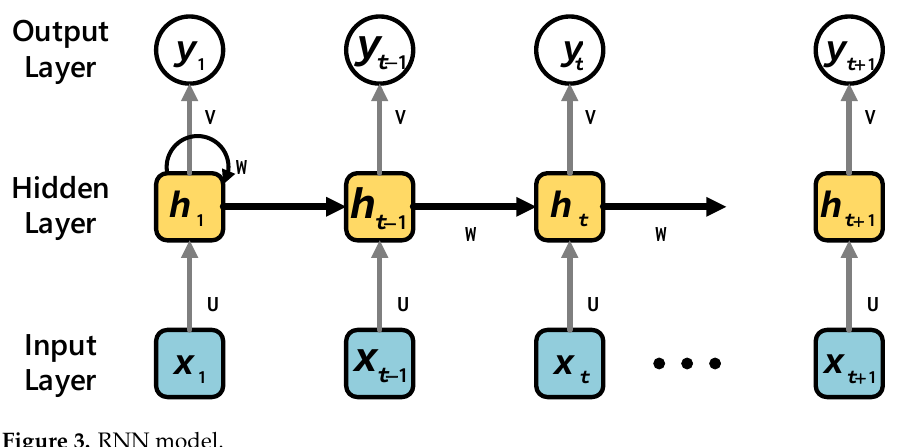
Figure 3. RNN model.